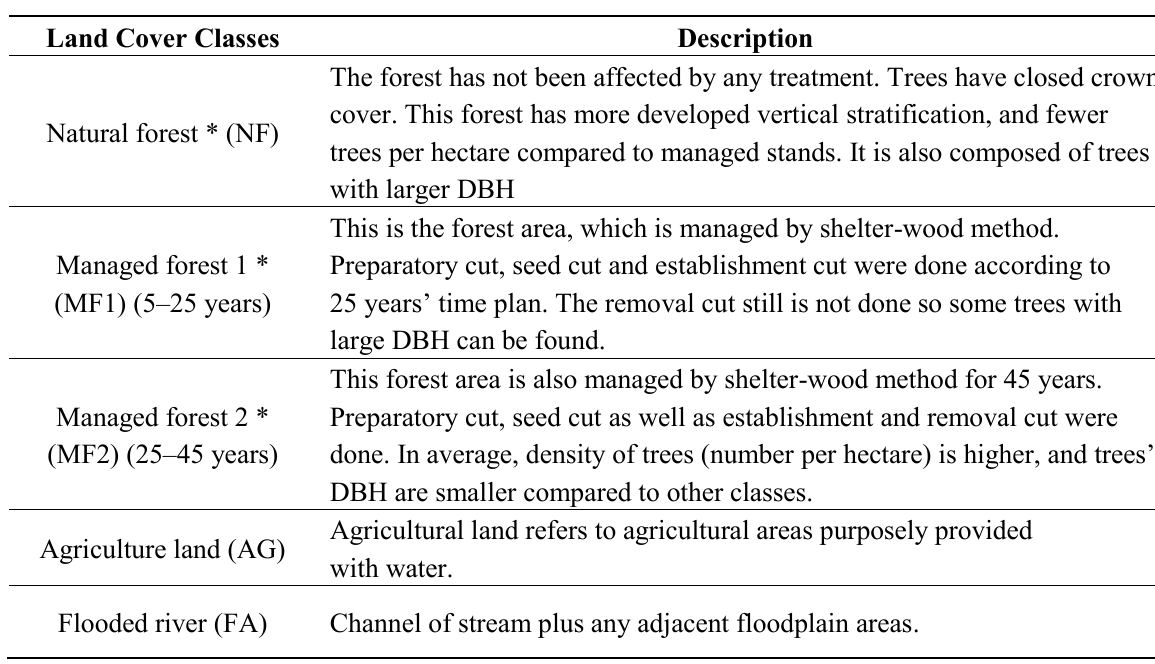
Table 1. Characteristics of main land use